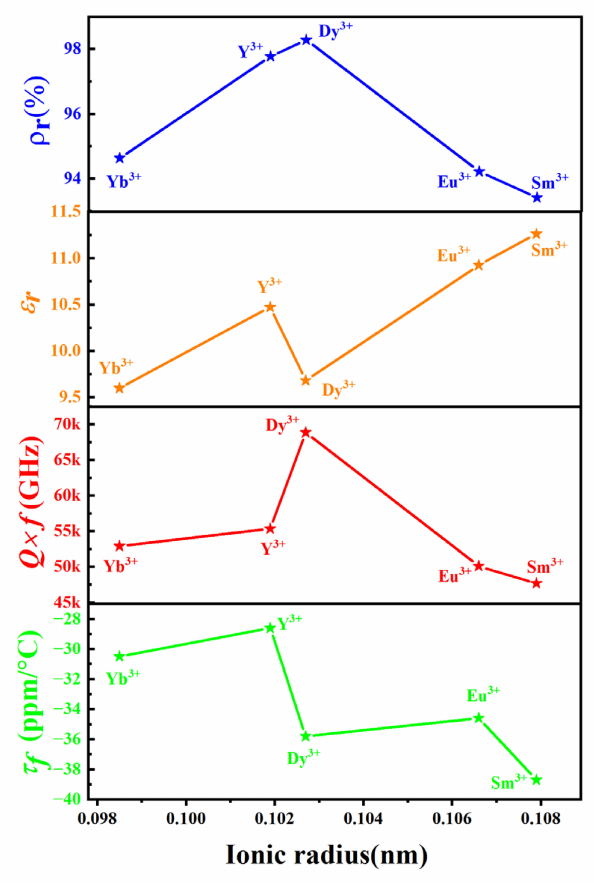
Figure 4. Microwave dielectric properties and ρ r of Y 2.95 R 0.05 MgAl 3 SiO 12